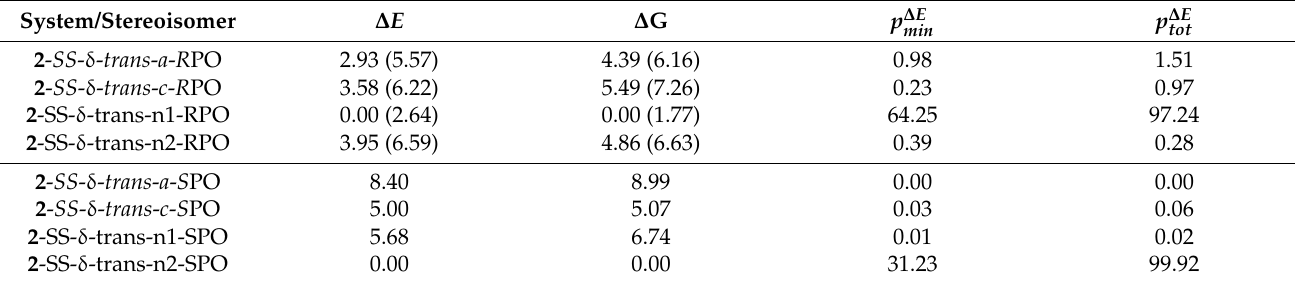
Table 3. Relative electronic-energy and free-energy values ( ∆ E and ∆ G , in kcal/mol) of the lowest-energy R PO and S PO epoxide complexes within each group of a , c , n1 , and n2 isomers of 2 - SS - δ - trans , along with the corresponding Boltzmann- computed values of the population of the respective R PO / S PO minimum-energy complex among all considered R PO / S PO structures ( p ∆ E , in %). Additionally, in the last column, the population of all R PO/ S PO complexes optimized for min each group of isomers among all considered R PO/ S PO structures ( p ∆ E , in %) is listed. The relative electronic energies/free tot energies of R PO/ S PO complexes were calculated with respect to the lowest-energy R PO/ S PO structure, while the numbers in parentheses correspond to the relative electronic-energy/free-energy values calculated with respect to the “global minimum” epoxide complex, 2 - SS - δ - trans - n2 - S PO. Note that all located minima correspond to the (out)-type